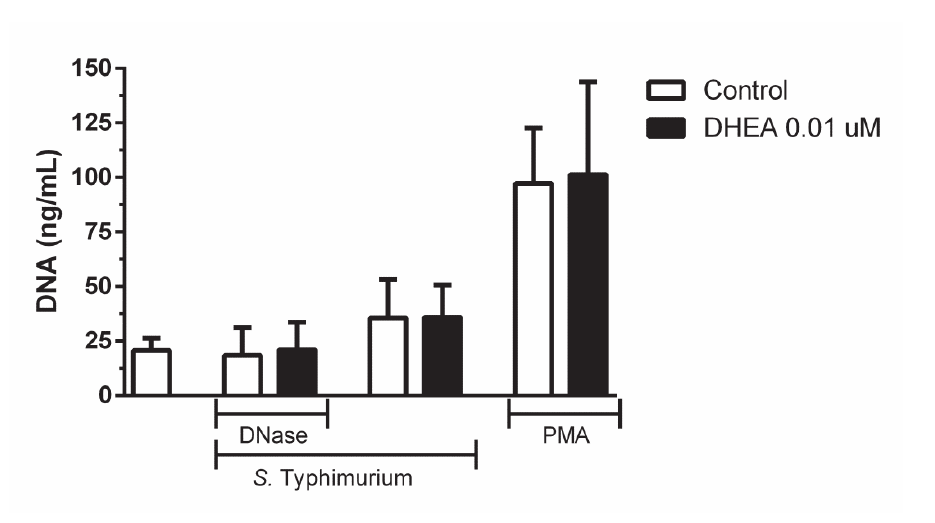
FIGURE 7 – DHEA have no effects on NET production. Neutrophils (2 x 105) were treated or not for 1 hour with 0.01 µM DHEA, then were incubated with PMA (0.162 µM) or S. Typhimurium (MOI=10) for 4 h, and the supernatants were collected for quantification of fragmented DNA released by cells. As a negative control the enzyme DNaseI (100 U/mL) was used 30 min before infection. For quantification, the supernatants were treated with 20 U/mL of the restriction enzyme EcoRI and HindIII, according to the manufacturer’s directions. NETs were quantified using the Quant-iT™ Picogreen® dsDNA kit. Data represent the Mean (SD) of 4 independent experiments performed on different days, with cells from 4 different